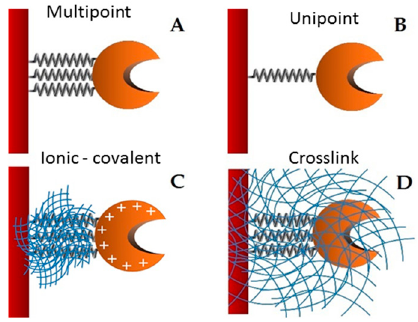
Figure 1. Schematic representation of the derivatives (enzyme immobilized + support) used in the present work. ( A ) GX; ( B ) CNBr (control); ( C ) GA; ( D ) GA-crosslink.